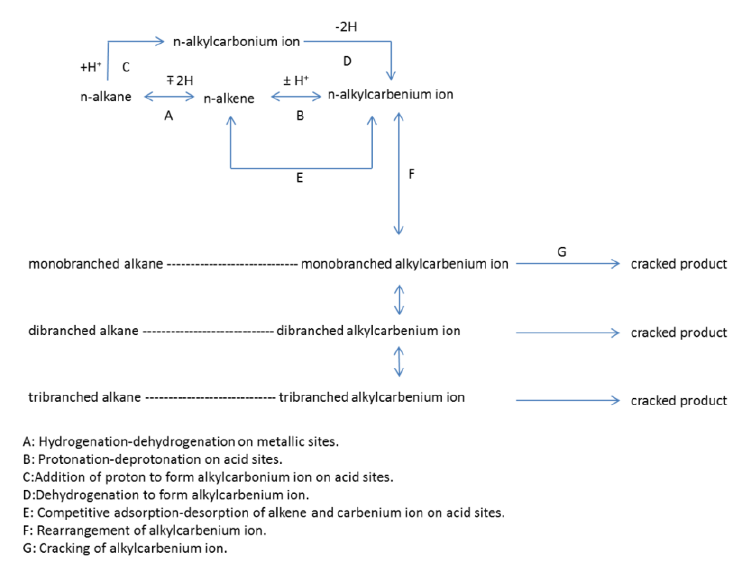
Figure 1. Proposed pathways of hydroisomerization and cracking reactions of n-paraffins by K. C. Park et al . in 2001 [ 9,